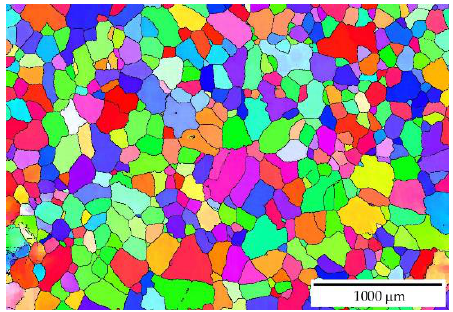
Figure 8. Isochronal ageing curves of the ( a ) microhardness HV0.1 changes and ( b ) relative resistivity changes of the AlMnYbZr AC and CR alloys.